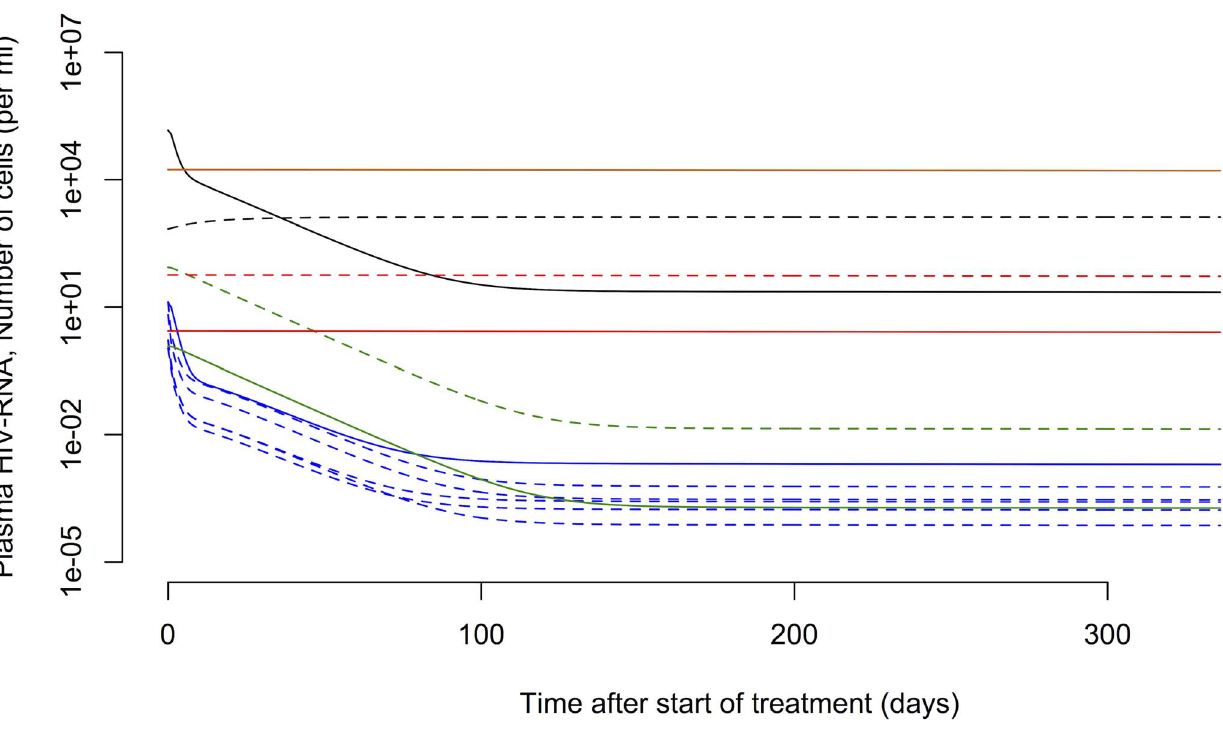
Figure 5. Dynamics of HIV-1-infected subpopulations during cART. The 12 different cellular subpopulations from Figure 3 (patient 112) are shown together with the virus. CD4 z target cells ( T ): black dashed line; actively infected cells during the intracellular eclipse phase ( I 1 to I 5 ): blue dashed lines; activated, virus-producing cells ( I 6 ): blue solid line; defectively infected cells ( D ): chocolate line; latently infected cells ( L 1 and L 2 ): red dashed and solid line, respectively; persistently infected cells ( M 1 and M 2 ): green dashed and solid line, respectively; virus particles ( V ): black solid line. The dynamics of the cellular subpopulations for all other patients are given in Text S1 .